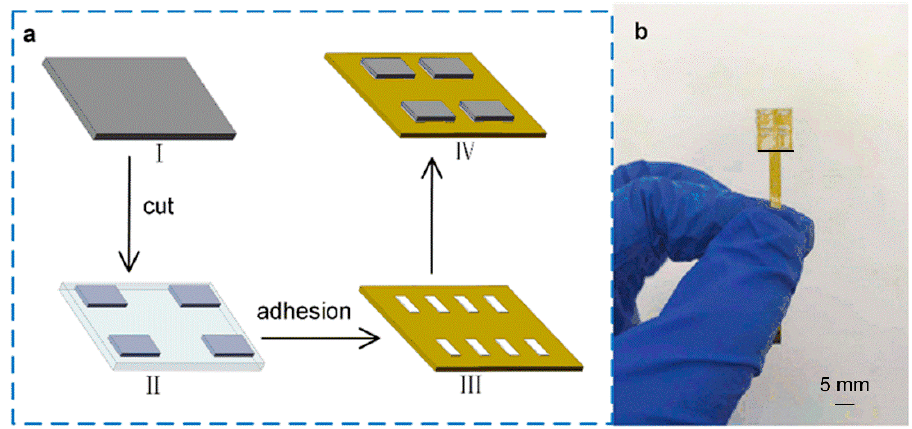
Figure 3. The fabrication processes of the tactile sensor and the photo of the tactile sensor. ( a ) The fabrication processes of the tactile sensor. ( b ) The photo of the fabricated tactile sensor.